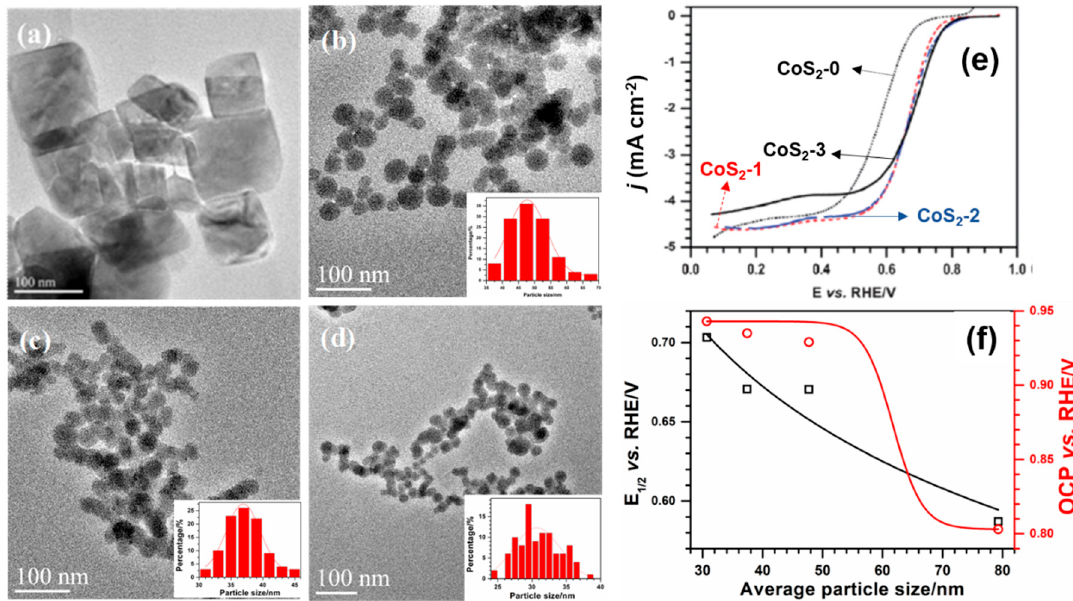
Figure 2. ( a – d ) High-resolution transmission electron microscope (HRTEM) images of CoS 2 -0 (without addition of hexa-decylcetyl-trimethylammonium (CTAB)), CoS 2 -1, -2, and -3 nanoparticles with the initial Co 2+ concentrations from 0.025 M to 0.075 M in the presence of 0.5 mM CTAB; ( e ) rotating disc electrode (RDE) curves of the four CoS 2 samples in O 2 -saturated 0.1 KOH at 1600 rpm at